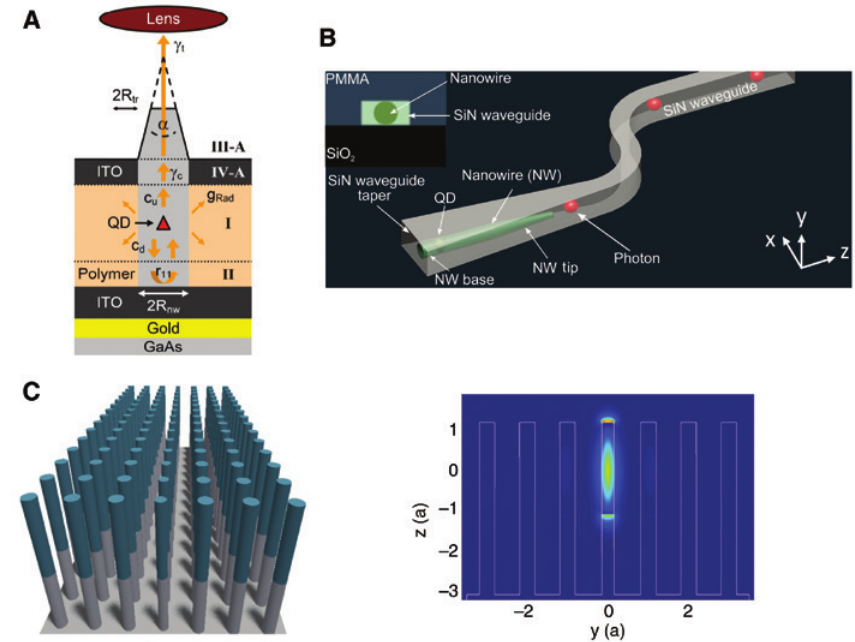
Figure 5: Illustrations of some proposed designs for future nanowire SPSs. (A) Electrically operated nanowire SPS with ITO used as a transparent top contact. (B) Scheme for on-chip integration of a nanowire SPS with planar waveguide designs. Selected nanowire SPS is first transferred to the substrate with a nanomanipulator, after which the SiN waveguide is fabricated. (C) Photonic crystal waveguide structure (left) realized with nanowires (with the prospect of including one with an embedded QD) and simulated mode profile (right) showing additional vertical light confinement due to the nanowire heterostructure. Figure reprinted with permission from: (A) Ref. [209], 2010 by the Optical Society of America; (B) Ref. [210], 2016 by the American Chemical Society; (C) (left and right) Ref. [211], 2014 by the American Physical